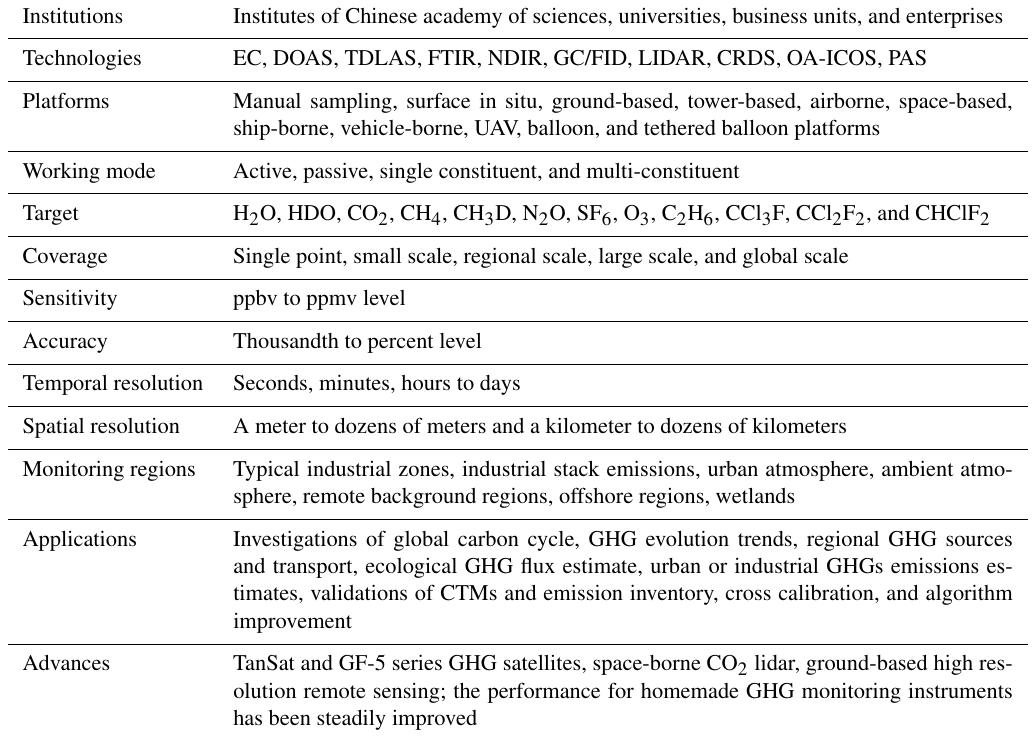
Table 1. Status of GHGs monitoring. Institutions